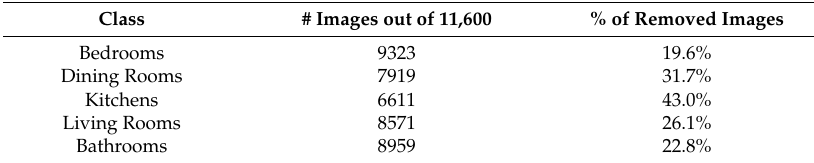
Table 1. Number of images for each class after cleaning.